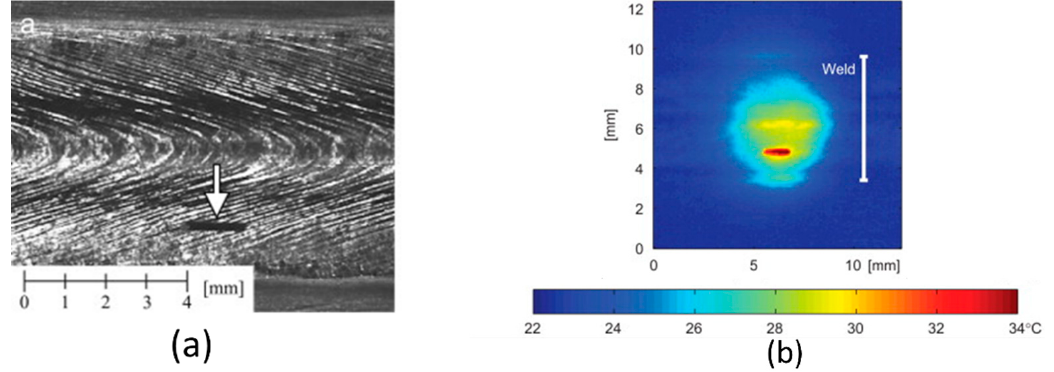
Figure 15. Defect detection by means of the thermography technology performed by Broberg [108]. ( a ) displays the defect (the arrow shows its position). ( b ) shows the captured thermal image, in which the defect can be recognised.